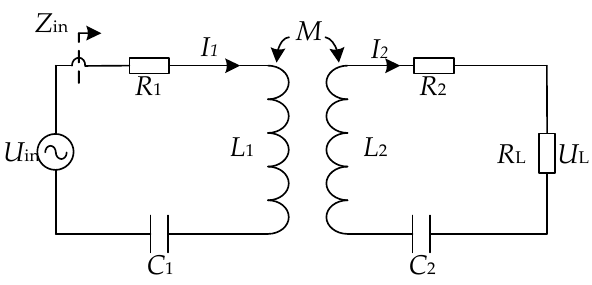
Figure 1. SS-type topology coupled circuit model.